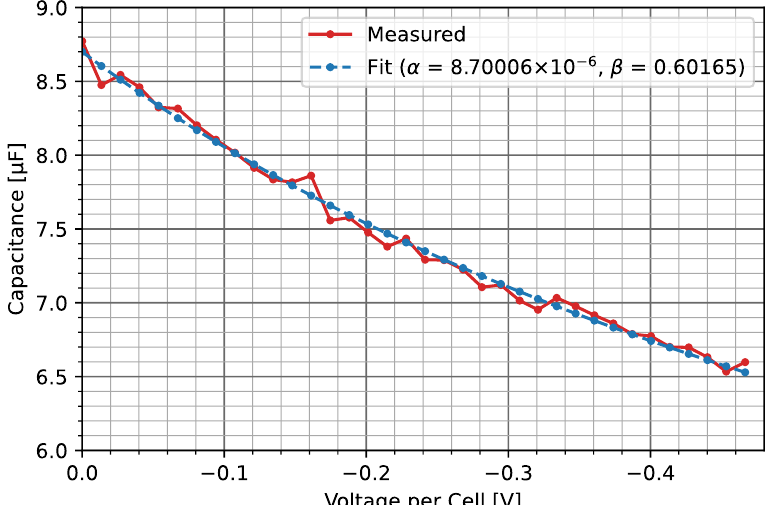
Figure 30. Large PV module measured and fit per-cell capacitance curves at multiple levels of reverse